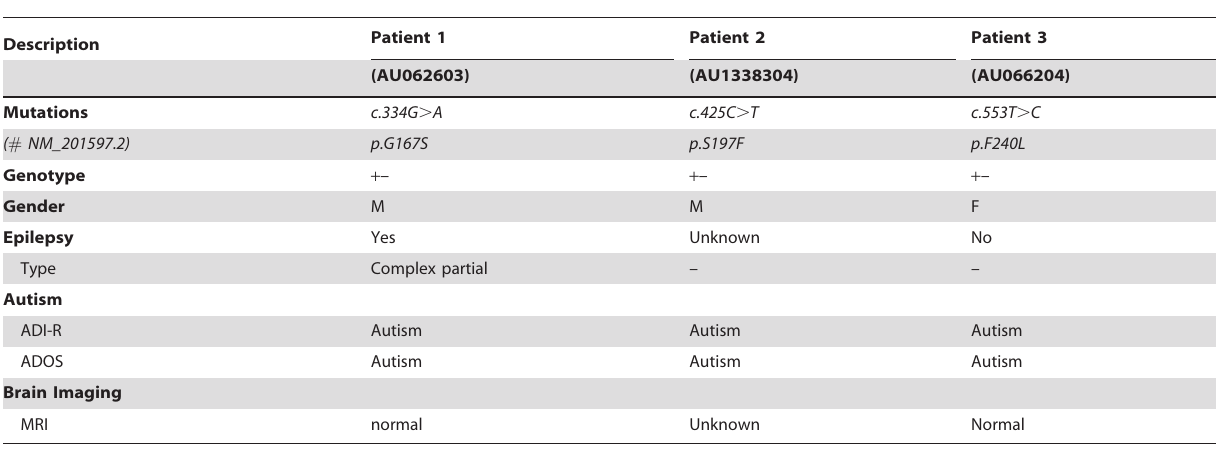
Table 1. Clinical Features of ASD patients with rare mutations in CACNB2